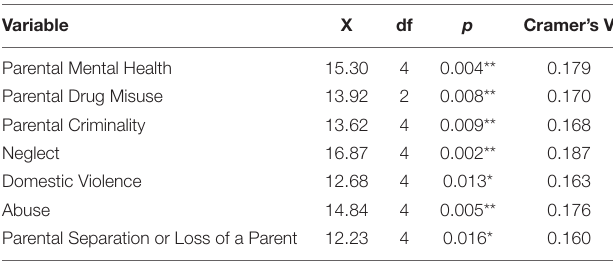
TABLE 3 | Chi-square analysis of the association between CYP diagnosed mental health difficulties and parental risk